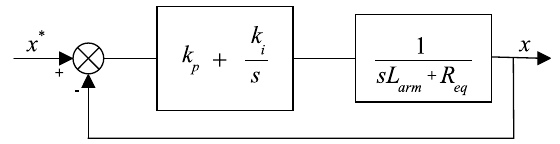
Fig. 7 Current inner loop unified control block diagram